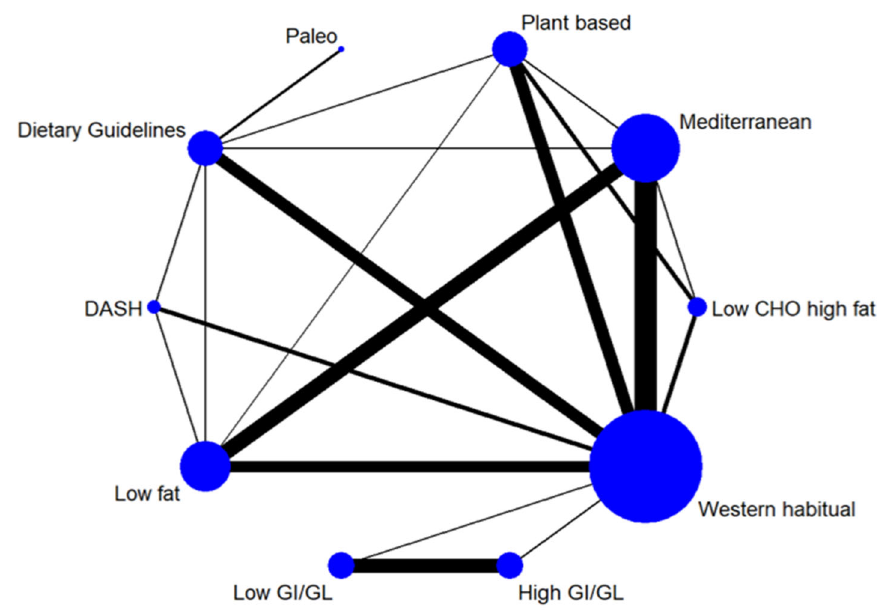
Figure 2. Network diagram for LDL cholesterol illustrating the available direct comparisons between different dietary patterns. The size of the nodes is proportional to the sample size of each dietary pattern intervention, and the thickness of the lines is proportional to the number of studies available. The number of studies for each dietary pattern were: Mediterranean diet ( n = 20); Dietary Approaches to Stop Hypertension ( n = 5); Paleo diet ( n = 2); Dietary guidelines-based diets ( n = 12); low GI/GL diet ( n = 9); plant-based diets ( n = 10); low-fat diet ( n = 14); low carbohydrate high-fat diet ( n = 4); high GI/GL diet ( n = 9); and western habitual diet ( n = 37).